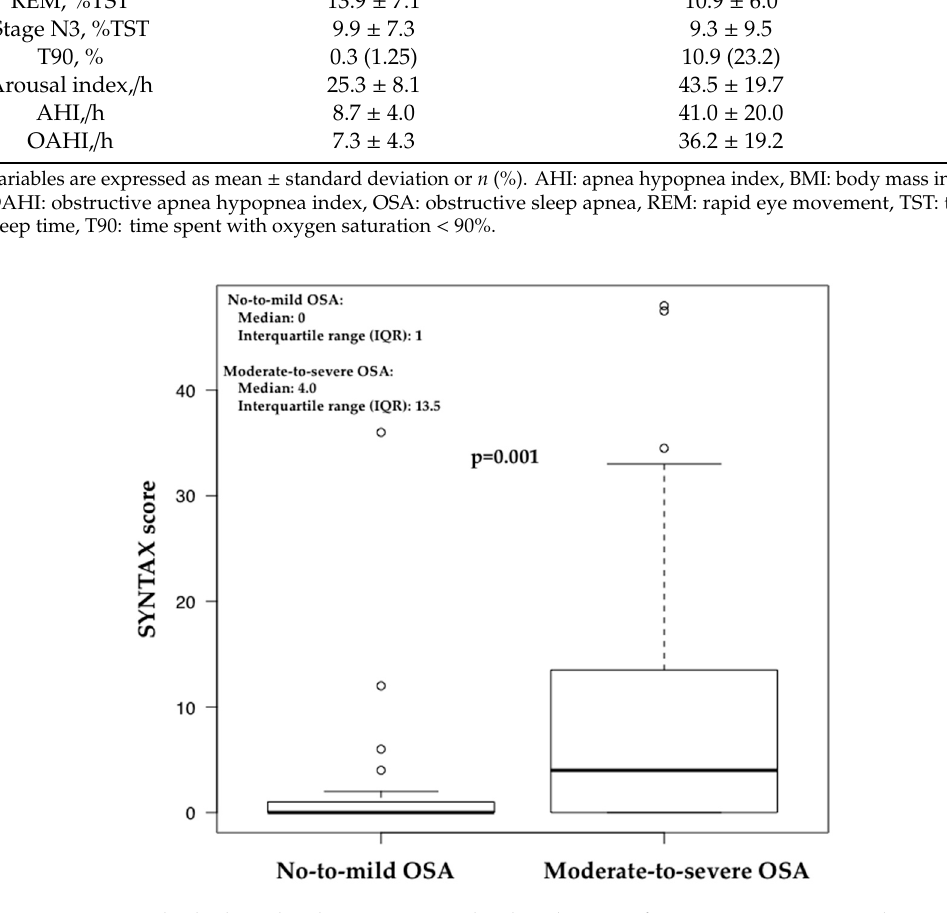
Figure 1. Box and whisker plot demonstrating the distribution of SYNTAX scores according to the severity of SA. The SYNTAX score was significantly greater in patients with moderate-to-severe SA than in those with no-to-mild SA (median and interquartile range (IQR), 4.0 and 13.5 vs. 0 and 1, respectively, p = 0.001). Table 1. Baseline characteristics of all subjects.